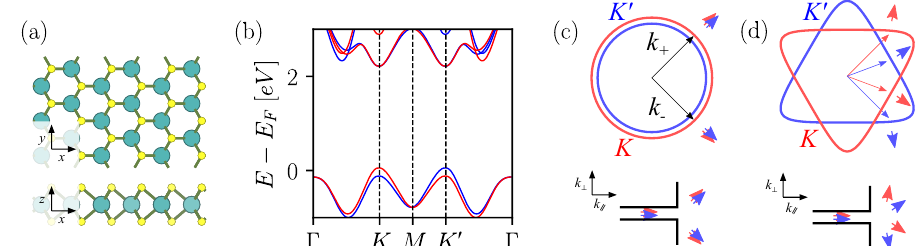
Figure 1: Atomic, electronic structure of monolayer MoS and the concept of spin 2 discrimination in transport based on band warping. (a) Crystal structure of MoS . Two 2 hexagonal planes of S atoms sit at both sides of the middle hexagonal plane constituted by Mo atoms. A top view shows that the atoms are organized in a honeycomb crystal structure. (b) Spin-resolved MoS band structure obtained from the tight-binding 2 model. The spin-orbit coupling breaks spin degeneracy and causes spin-momentum locking as illustrated by colored (blue = spin-up; red = spin-down) bands. (c, d) Top: schematic illustration of 2D Fermi surfaces, charge carrier momenta (arrows) and their group velocities (short colored arrows) with (d) or without (c) trigonal band warping effect. Colors denote the coupled spin and valley of charge carriers. Bottom: a schematic illustration of charge carriers leaving a nanoconstraint towards a semi- infinite 2D plane. Depending on the trigonal warping effect, charge carriers with different spin and valley index are either aligned along the same set of directions (c) or become split (d). In the latter case, the geometry of a 2D device can be used to discriminate charge carriers with respect to their